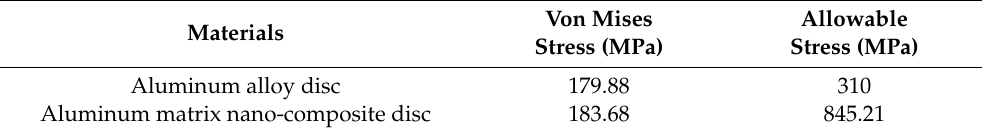
Table 2. Result of von Mises stress of aluminum alloy and aluminum alloy nano-composite venti- lated